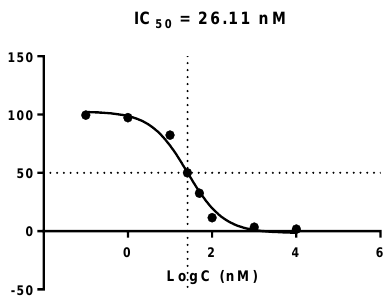
Figure 4. Dose-response curve of 5b was used for determining the IC 50 value (nM) after Western blotting analysis.